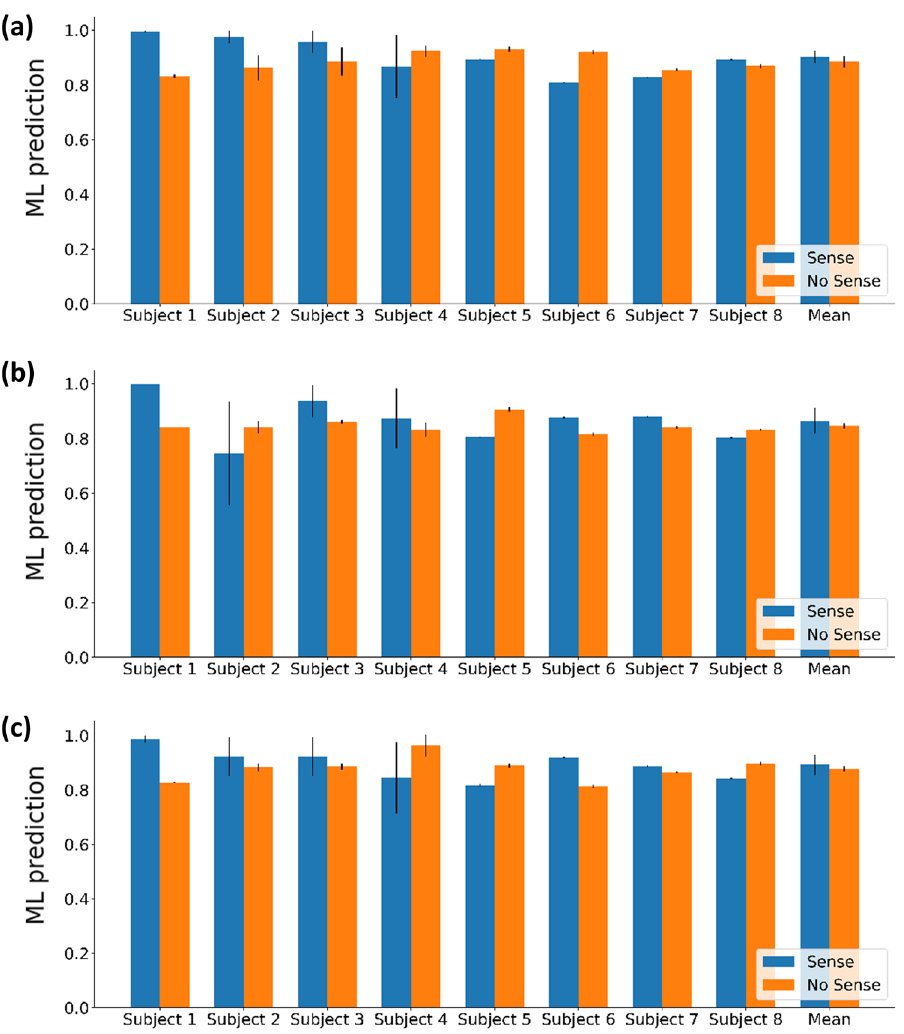
Figure 3. Speckle-based ML model sensory recognition for each subject and the average predictions for all participants for each of the three senses, including value margins for all tested subjects. Prediction details: First subject—male, age 29; Second subject—male, age 55; Third subject—male, age 74; Fourth subject—female, age 25; Fifth subject—male, age 49; Sixth subject—female, age 35; Seventh subject—male, age 50; Eight subject— male, age 55. The senses of smell ( a ), hearing ( b ), and taste ( c ) are all represented by Speckle-based DNN predictions. While the corresponding sense was active, the blue columns in each of the figures represents model predictions, while the orange columns represents model predictions when the sense was